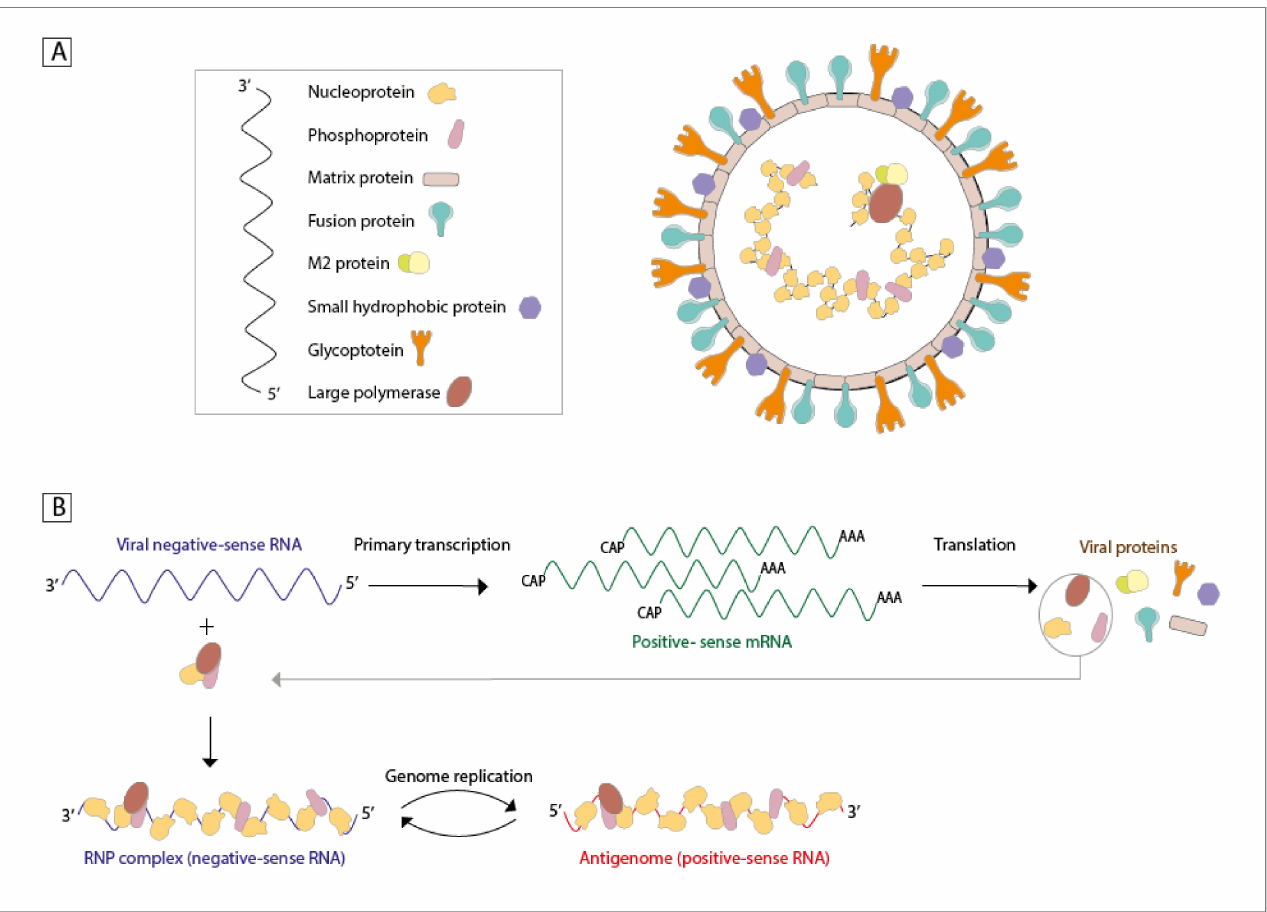
Figure 1. Structure, genetic material, and replication cycle of human metapneumovirus (hMPV). ( A ) hMPV is a negative- sense and single-stranded RNA virus, with nine structural proteins in its genome. These proteins are found in the genome in the following order: 3 (cid:48) -nucleoprotein (N), phosphoprotein (P), matrix proteins (M), fusion protein (F), M2-1/2 protein, small hydrophobic protein (SH), glycoprotein (G), and large polymerase protein (L)-5 (cid:48) . ( B ) The replication cycle of hMPV involves the synthesis of positive-sense mRNA, which will be translated into the indicated viral proteins. These viral proteins are essential for replicating the virus, as they will bind to the initial viral negative-sense RNA, forming the ribonucleoprotein (RNP) complex. This RNP complex will replicate the negative-sense RNA into positive-sense RNA, ultimately generating many copies of the negative-sense RNA genome for newborn viral